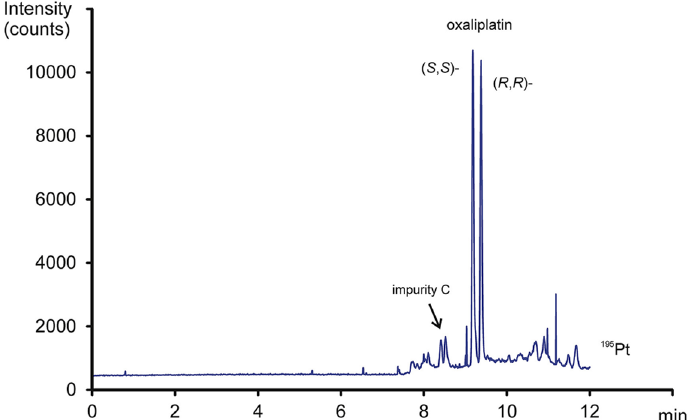
Figure 7. Separation of oxaliplatin enantiomers in urine using CE-ICP-MS. BGE: sodium borate buffer pH 9.5, ionic strength 40 mmolL − 1 , with 60 mg/mL sulfated - β -CD; voltage: 30 kV; monitoring of 195 Pt isotope. Both Figure and Figure caption is adapted from Sebestova et al. [24], with permission from Elsevier.